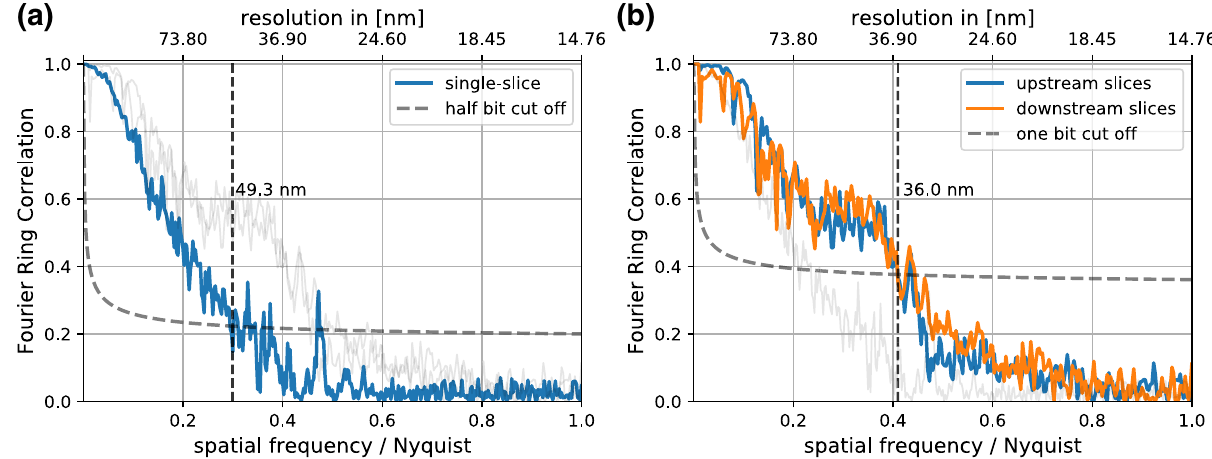
Figure 4. Estimated resolutions of the single polyimide foil experiment using Fourier ring correlation: ( a ) using two single slice reconstructions from halved datasets ( b ) using the two multi-slice reconstructions with inverted initialization order. The light gray lines show the FRC of the respective other reconstructions for an easier comparison. The figure was created using matplotlib 35 (version 3.1.3 36